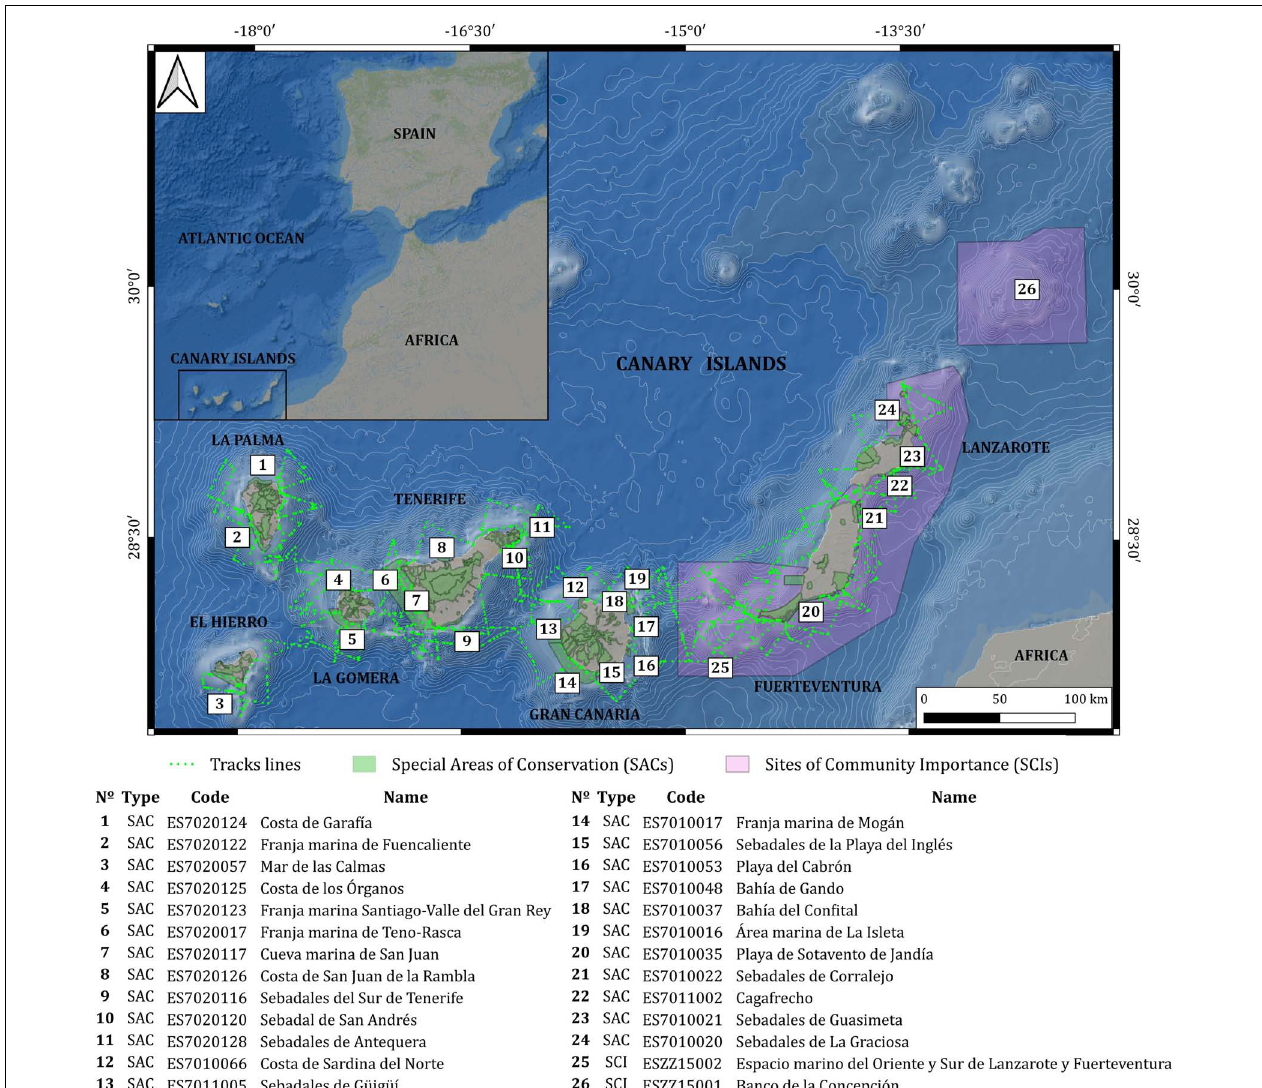
FIGURE 1 | Map of the survey area location, Canary Islands Archipelago, including the Special Areas of Conservation (SACs; green color), the Sites of Community Importance (SCIs; pink color) and the surveyed spatial trajectory (- - - tracks